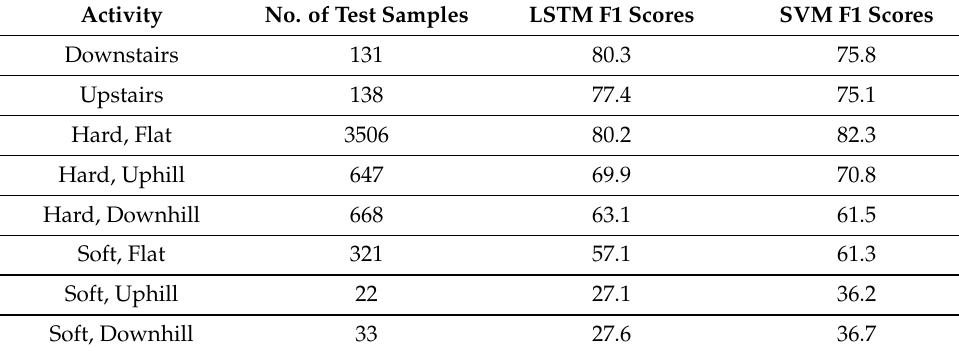
Table 8. Mean F1 Scores for Level 2 Label